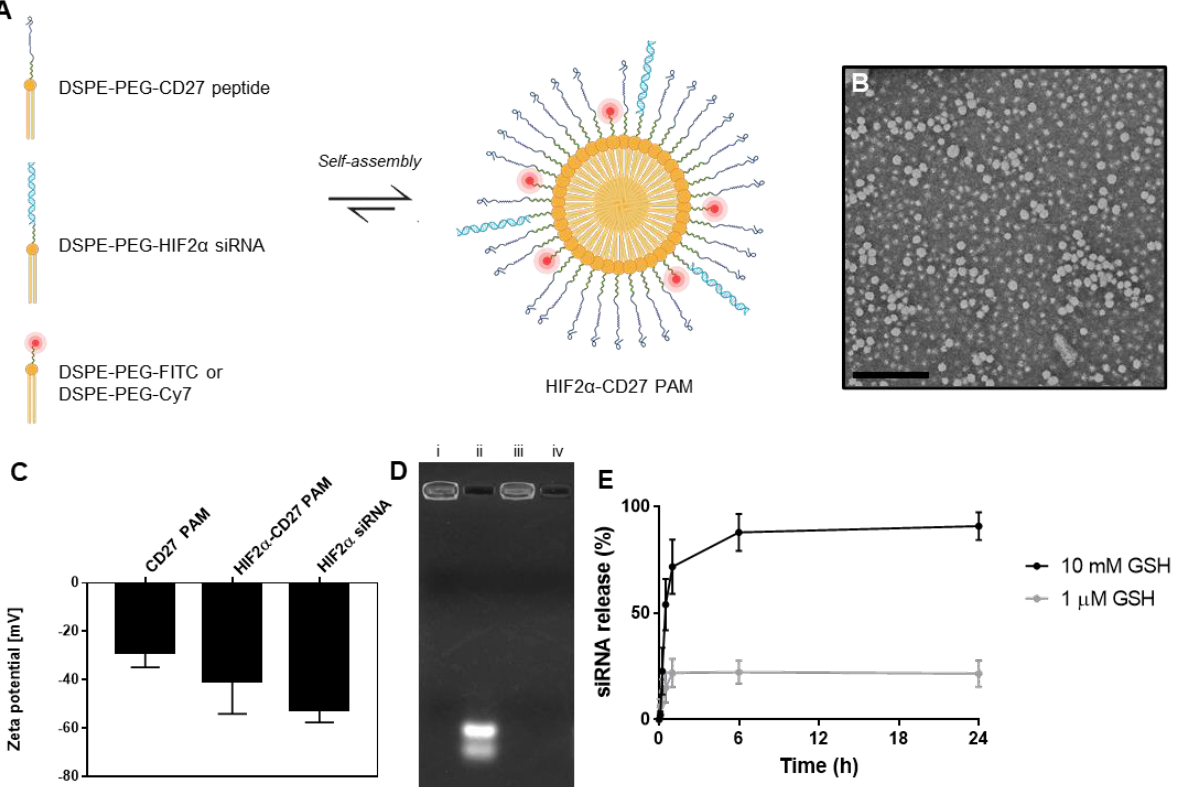
Figure 1. Physicochemical characterization of HIF2α -CD27 PAMs. ( A ) Schematic of HIF2α -CD27 PAM self-assembly. ( B ) Transmission electron micrograph of HIF2α -CD27 PAMs. Scale bar = 200 nm. ( C ) Zeta potential of CD27 PAMs before and after HIF2α siRNA incorporation. N = 3. ( D ) Gel